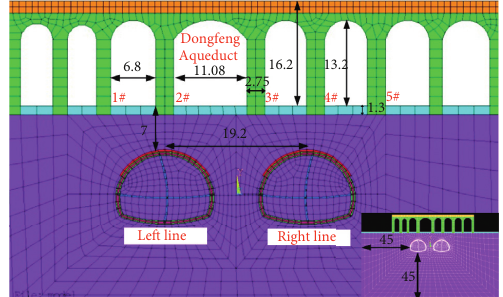
Figure 6: Calculation model (m). Table 1: Values of calculation parameters for aqueduct structure.